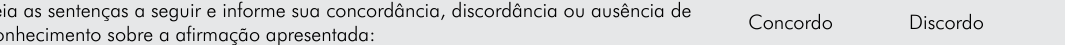
Table 1. Original and validated final version of the Brazilian Knowledge Scale about Sports Doping in Dentistry (B-KSSDD) and scores added to the total score according to the participants’ responses.